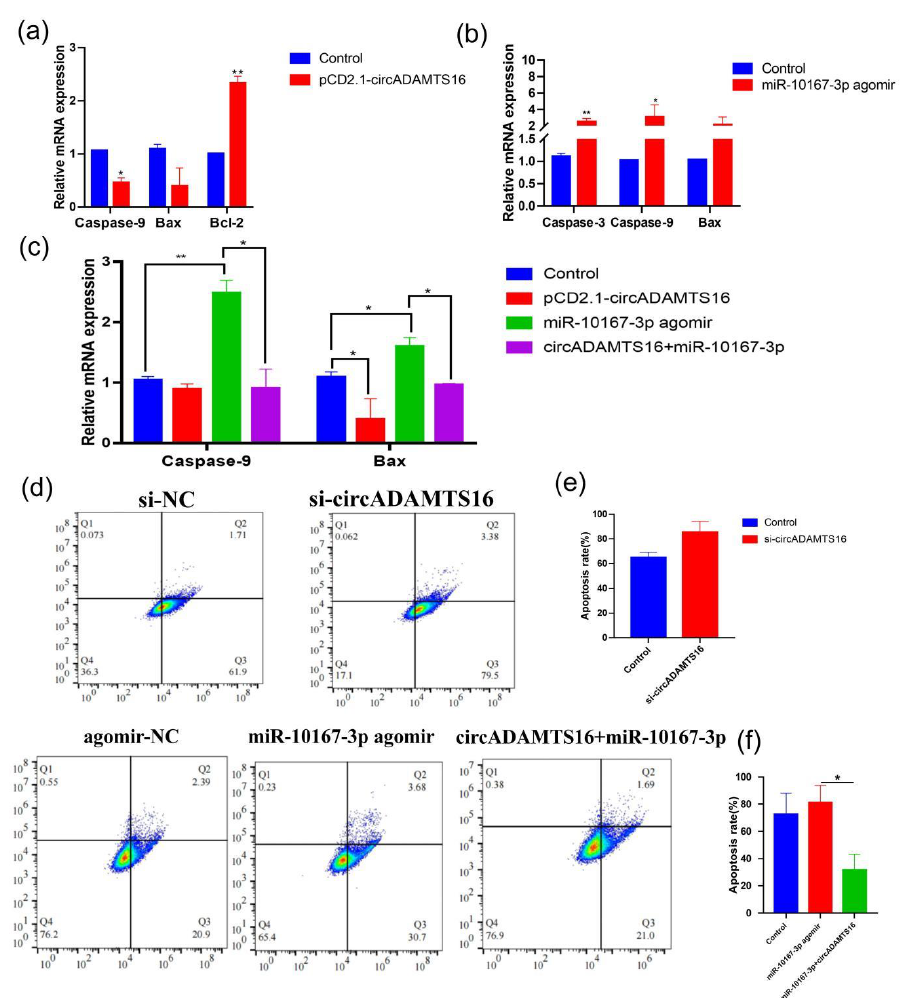
Figure 3. circADAMTS16 promotes the proliferation of bovine adipocytes by targeting miR-10167- 3p. ( a , b ) qPCR was used to detect the mRNA expression levels of proliferation genes CDK2 and CDK4 after transfection of pCD2.1-circADAMTS16 and miR-10167-3p agomir, respectively. ( c ) the expression levels of proliferation genes CDK2 and CDK4 were detected after co-transfection of cir- cADAMTS16 and miR-10167-3p agomir into bovine adipocytes. ( d , e ) The viability of pCD2.1-circA- DAMTS16 and miR-10167-3p agomir transfected cells was detected by CCK-8. ( f , g ) Cell prolifera- tion was detected by EdU. ( h , i ) Cell cycle was analyzed by flow cytometry (pCD2.1-NC was empty, and agomir-NC was used as the control of specially synthesized agomir). Scale bar indicates 200 μm. * p < 0.05, ** p < 0.01.